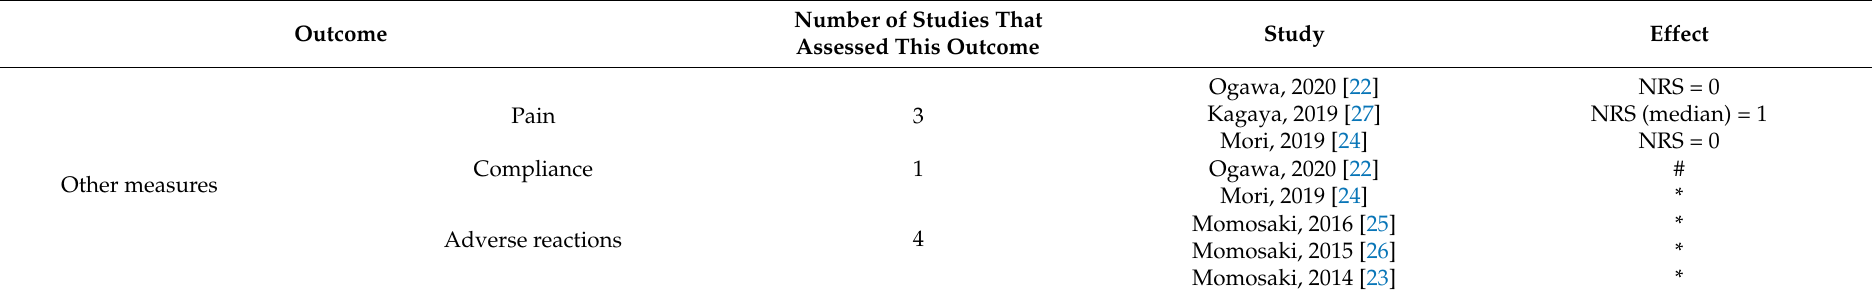
Table 3. Cont . Outcome